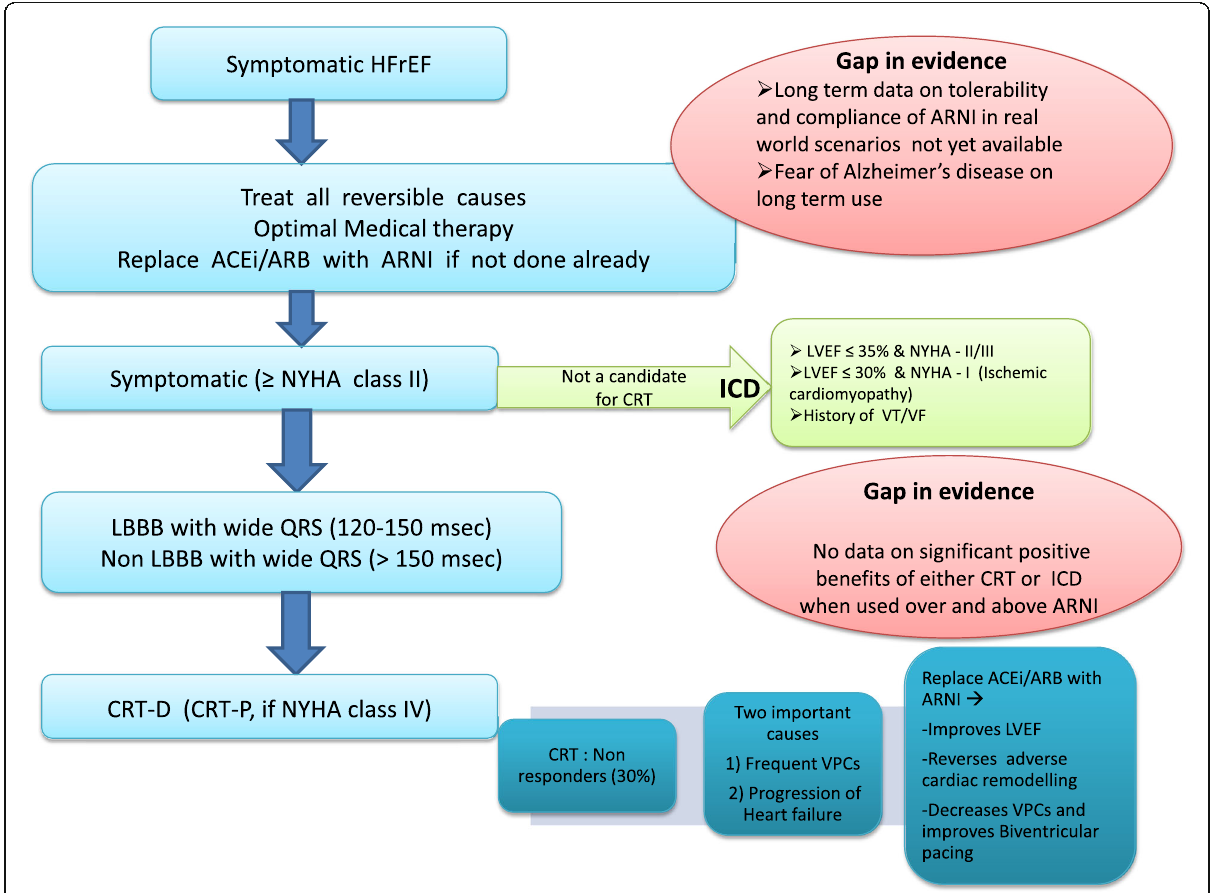
Fig. 1 Proposed algorithm for management of heart failure with reduced ejection